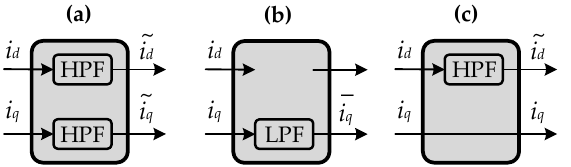
Figure 3. Different signal filters for i d and i q components, determining the required functionality of the APF system: ( a ) for higher harmonic reduction, ( b ) for reactive power compensation, and ( c ) for both ( a ) and ( b )